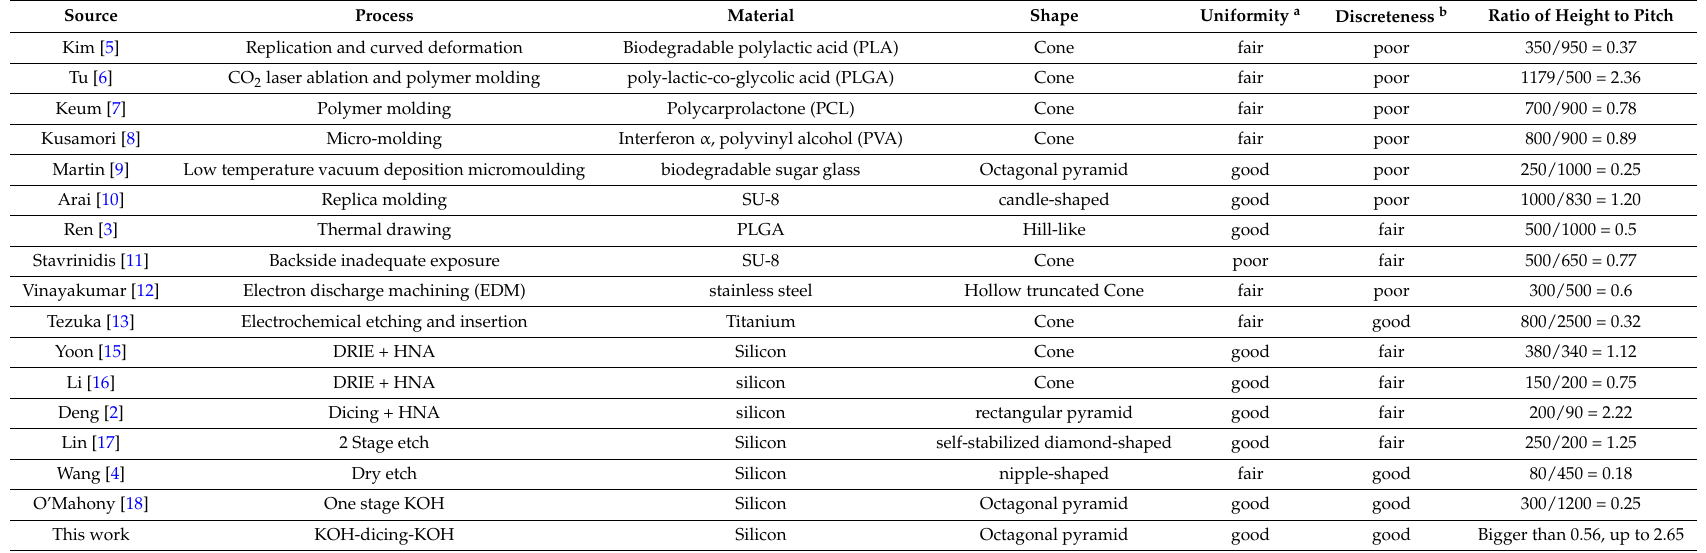
Table 1. Diverse microneedle